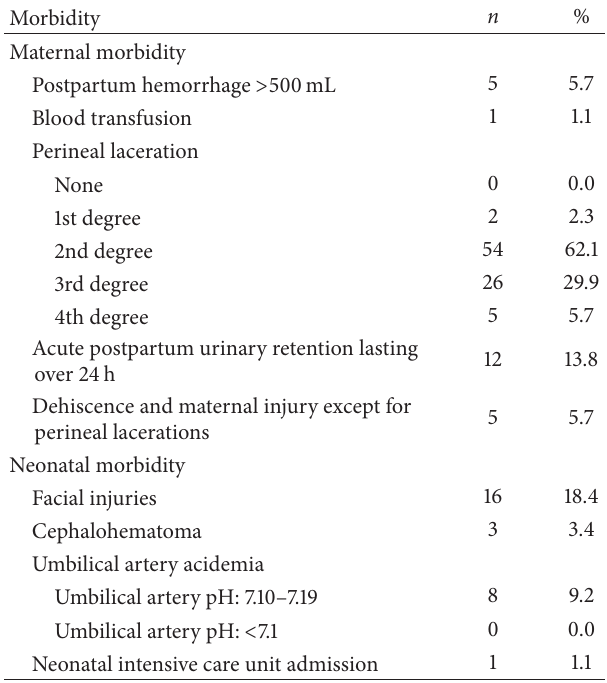
Table 2: Morbidity associated with Naegele forceps